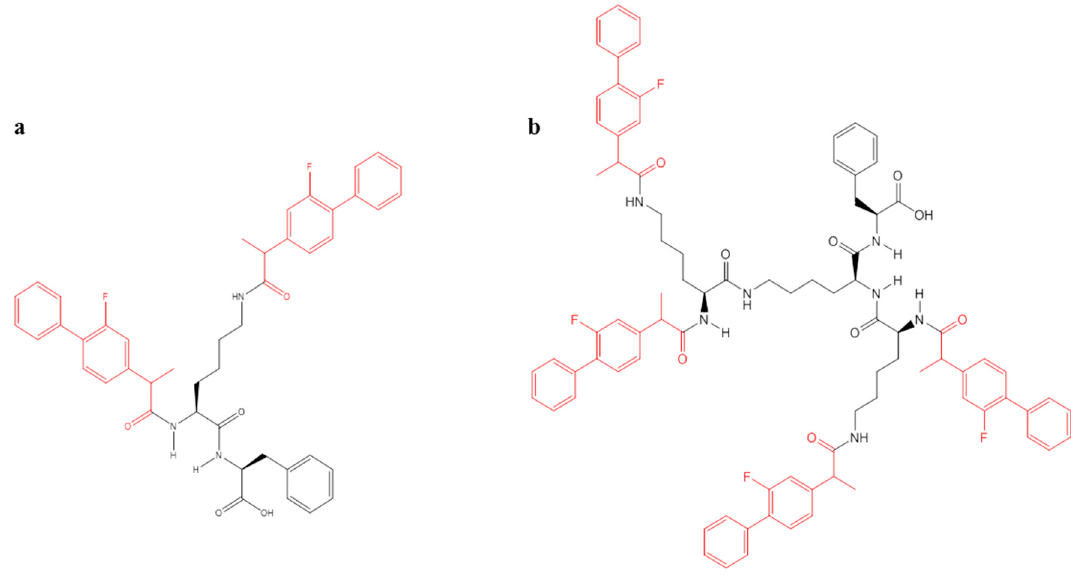
Figure 8. Chemical structure of ( a ) G0K-FP with MW 745 Da, ( b ) G1K-FP MW: 1454.68 Da (using ChemDraw Professional 15).